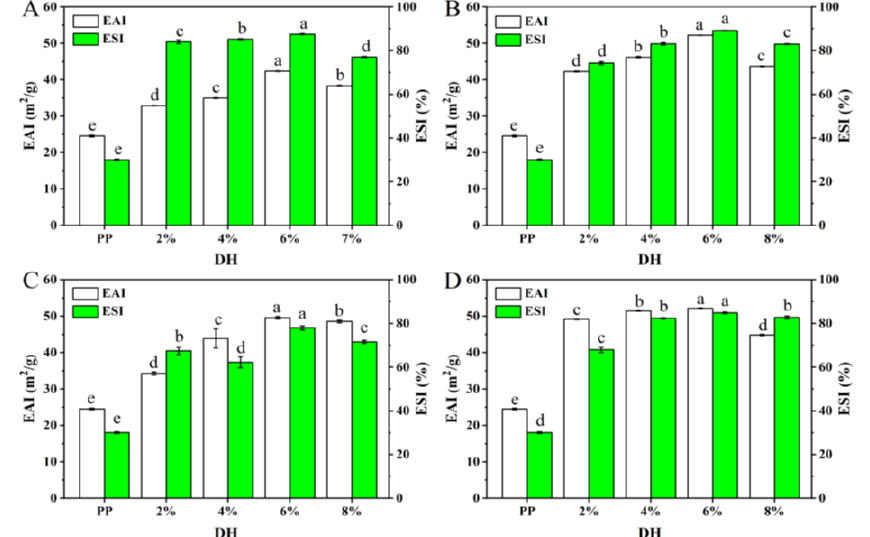
Figure 9. The EAI and ESI of PP and PP with different DH samples (( A – D ) are flavourzyme, neutrase, alcalase, and trypsin treatment, respectively). The different superscript letters of same index indicate significant difference ( p < 0.05).